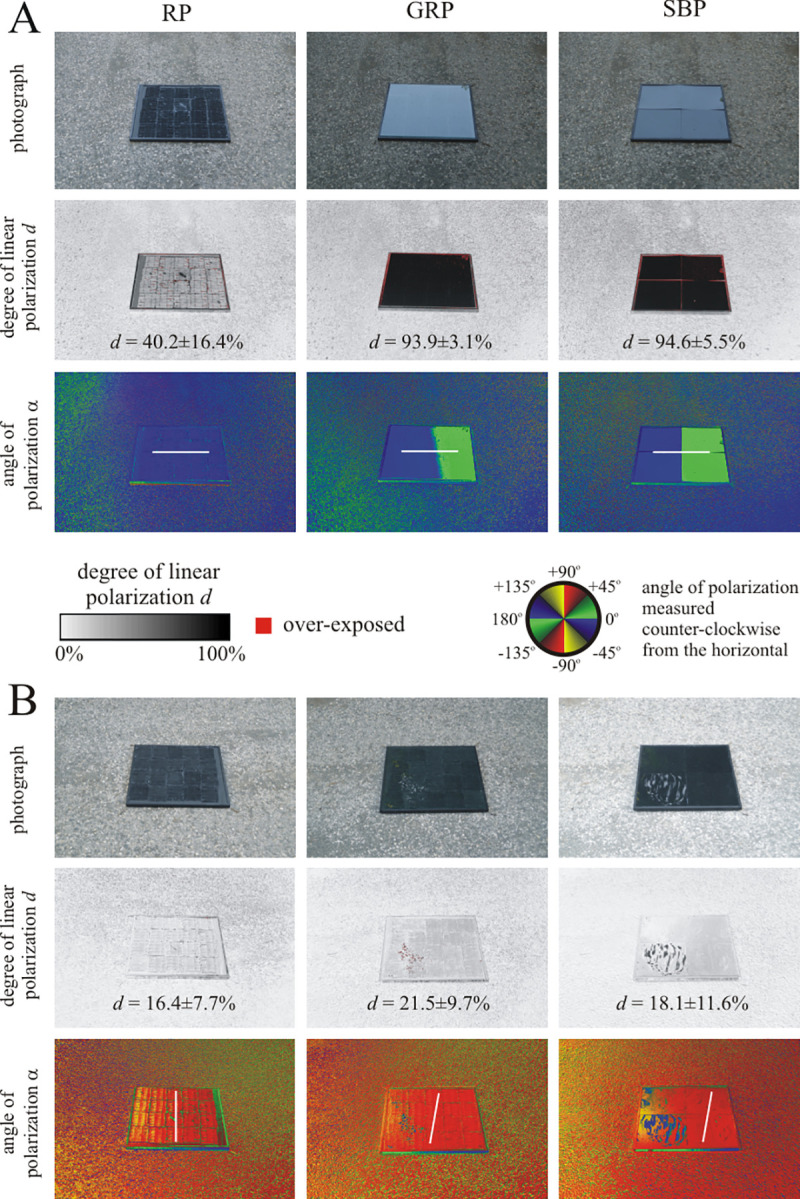
Photographs and patterns of the degree and angle of polarization of the three test surfaces (RP: Rose petal, GRP: Glass-covered rose petal, SBP: Smooth black plastic) laid on a dry asphalt road in the field experiments with mayflies measured with imaging polarimetry at 450 nm (blue).In A), the polarimeter’s optical axis pointed toward East, approximately parallel to the antisolar meridian, when light from the clear sky was reflected off the test surfaces. In B), the polarimeter’s optical axis pointed toward South, approximately perpendicular to the antisolar meridian, when light from the forest vegetation was reflected off the test surfaces. The tilt angle of the optical axis in both cases was -35° from the horizontal. The d-values are given in the degree of polarization patterns averaged for the whole test surface. In the angle of polarization patterns, the white bars show the average directions of polarization of the test surfaces.